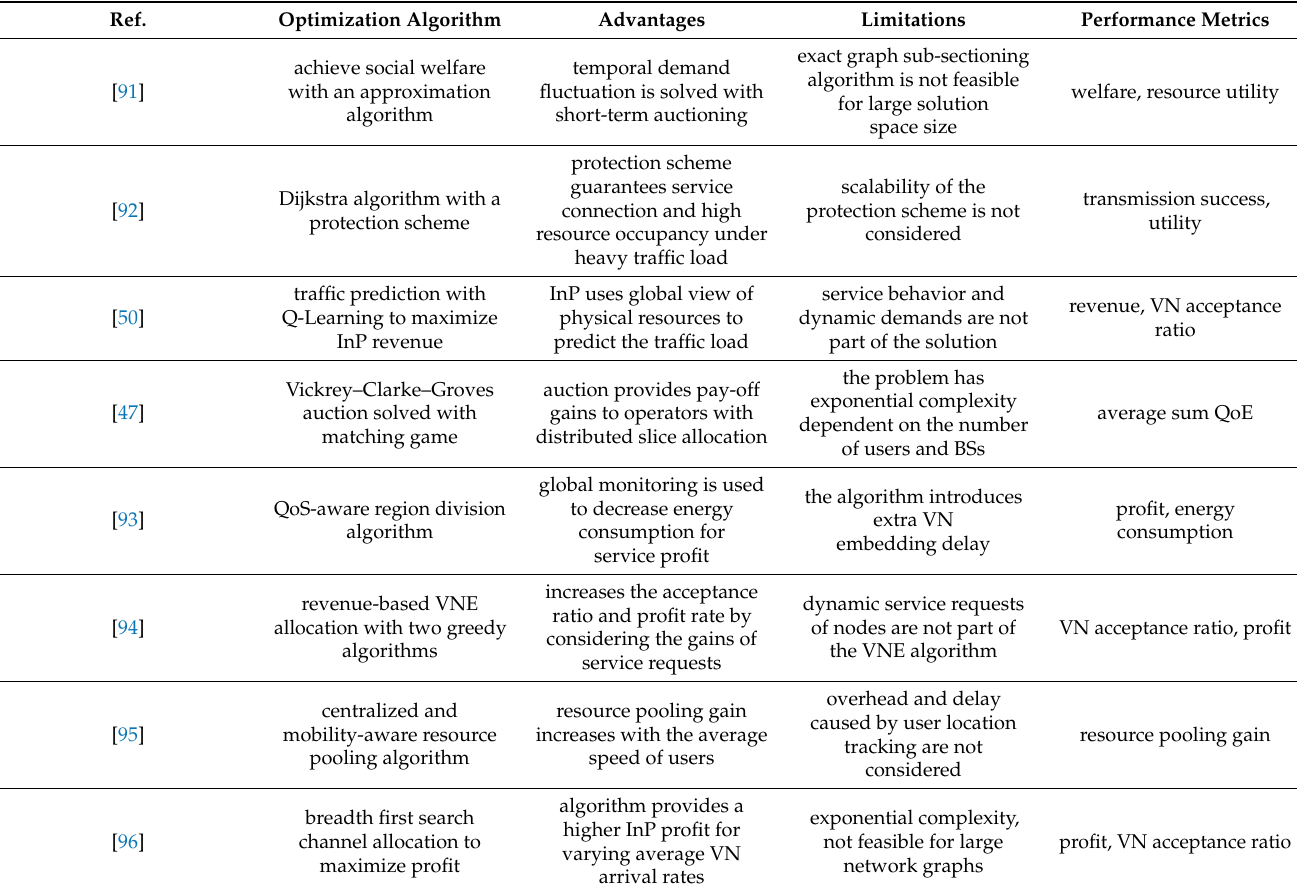
Table 6. Analysis of Virtualized Resource Allocation